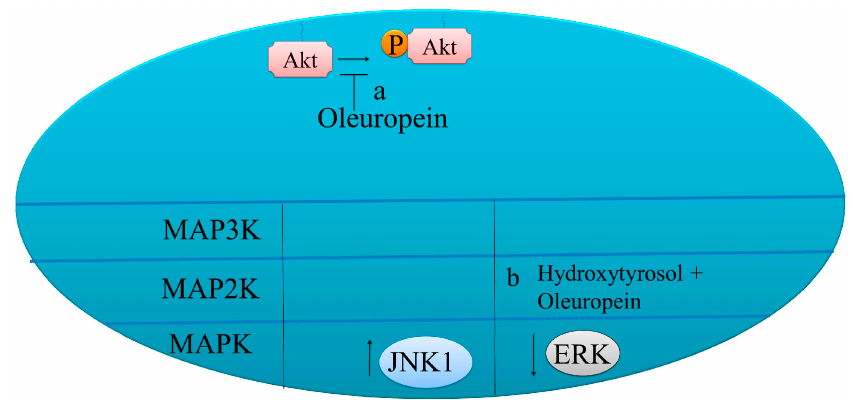
Figure 3. Pro-apoptotic molecular mechanisms of oleuropein in cancer cells. ( a ) Oleuropein mediated reduction of p-AKT levels. ( b ) Oleuropein enhanced p-JNK levels and reduced ERK1/2.